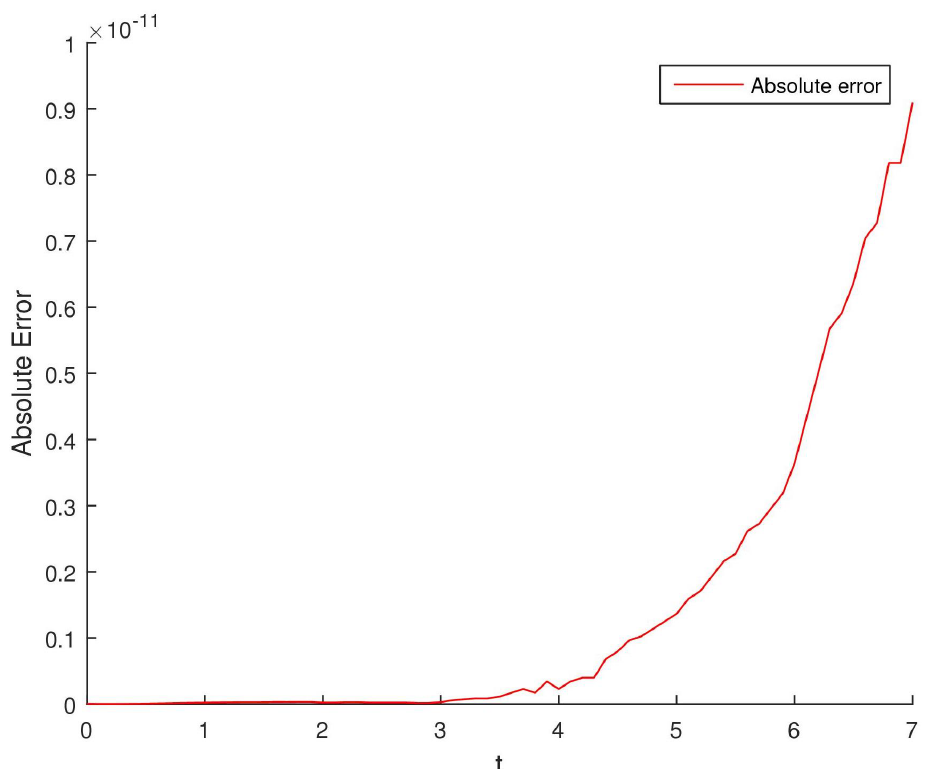
Figure 16. The absolute error of Example 5 for t ∈ [ 0,7 ] .